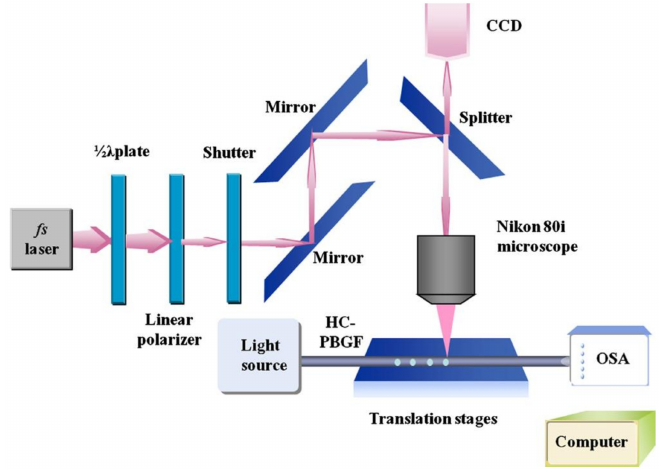
Figure 12. The femtosecond (fs) laser system for fabricating microchannels in an HC-PBGF